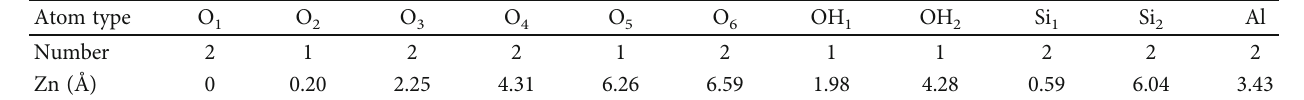
Figure 3: Experimental cation exchange protocol. Table 2: The z atomic coordinates within the 2:1 layer framework along the c ∗ axis